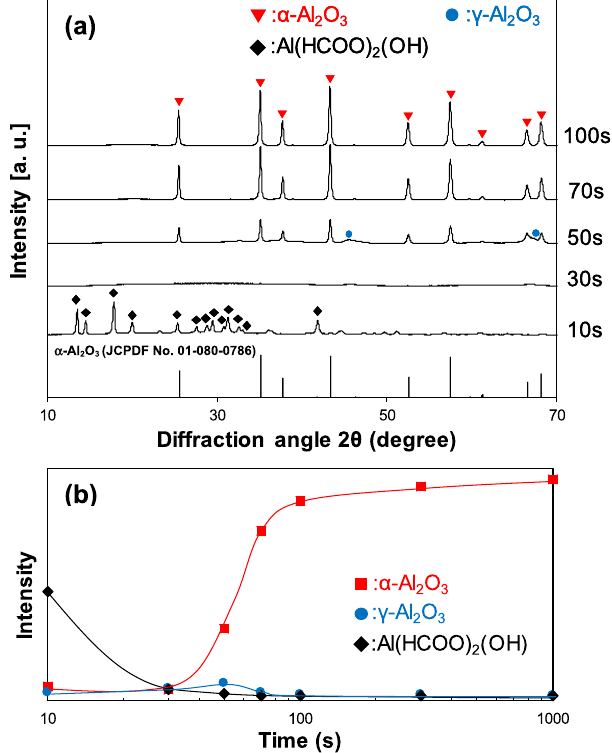
Figure 2. Evolution of the crystal phases during transformation to α -Al 2 O 3 at 1200 °C; ( a ) a series of XRD spectra; ( b ) the peak intensities of α -Al 2 O 3 (2 θ = 43.3°), γ -Al 2 O 3 (2 θ = 67.6°), and Al(HCOO) 2 (OH) (2 θ = 17.8°) for the samples heated for different soaking time. For comparison, the peaks of α -Al 2 O 3 (JCPDF No. 01-080- 0786) are also shown in the